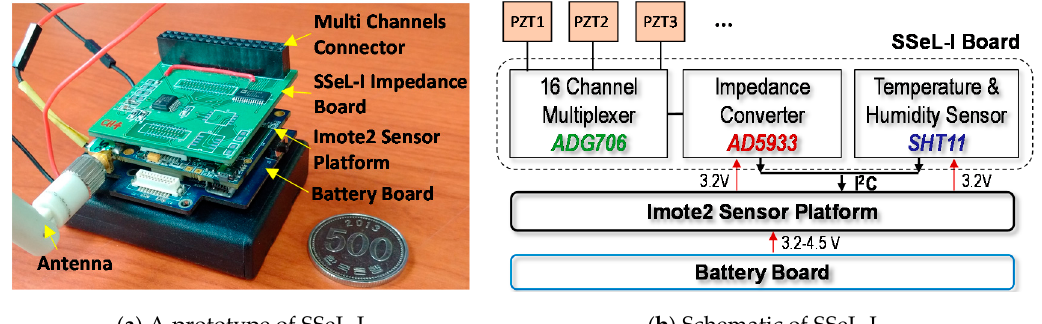
Figure 11. Wireless SSeL-I impedance sensor node.